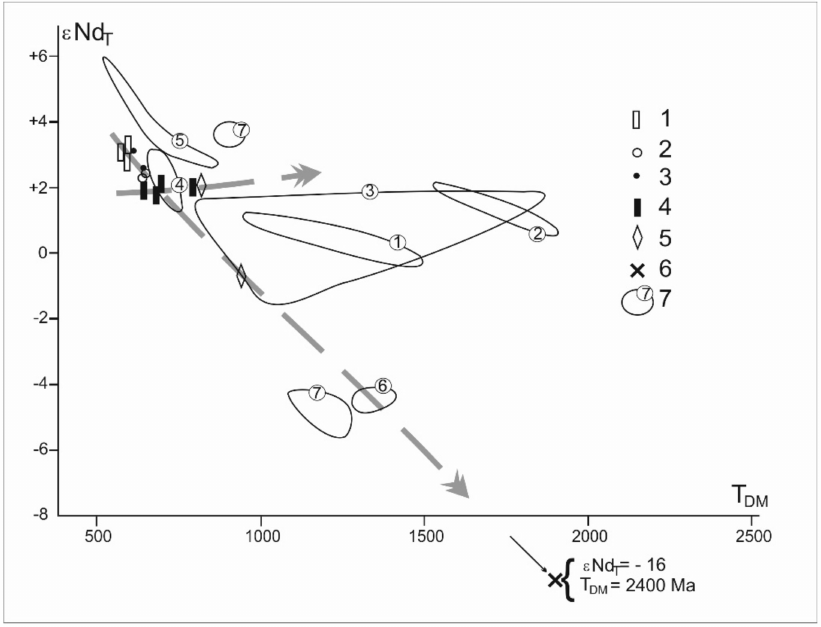
Figure 12. Sm–Nd reconstruction of the age for the Kresty Massif of the Kresty volcano–plutonic structure rocks, composition fields of volcanic and intrusive complexes of the Maimecha-Kotuy alka- line province and Taymyr lamproites on the ε Nd T –T DM diagram: (1) monticellitolites; (2) melilitolites and melilite-bearing olivinites; (3) melanephelinites; (4) olivinites, wehrlites and clinopyroxenites; (5) trachydolerites and trachyandesites; (6) alkaline syenite. (7) variation fields are shown with thin lines: 1 (cid:13) volcanites of the Pravoboyarskaya suite; 2 (cid:13) rocks of the Onchukanskaya suite; 3 (cid:13) alkaline effusives of the Tyvankitskaya suite; 4 (cid:13) nephelinites of the Delkanskaya suite; 5 (cid:13) picrites of the Maimecha suite; 6 (cid:13) lamproites of the Taimyr peninsula; 7 (cid:13) lamproites of the Chyia complex (Gorny Altai region, Southern